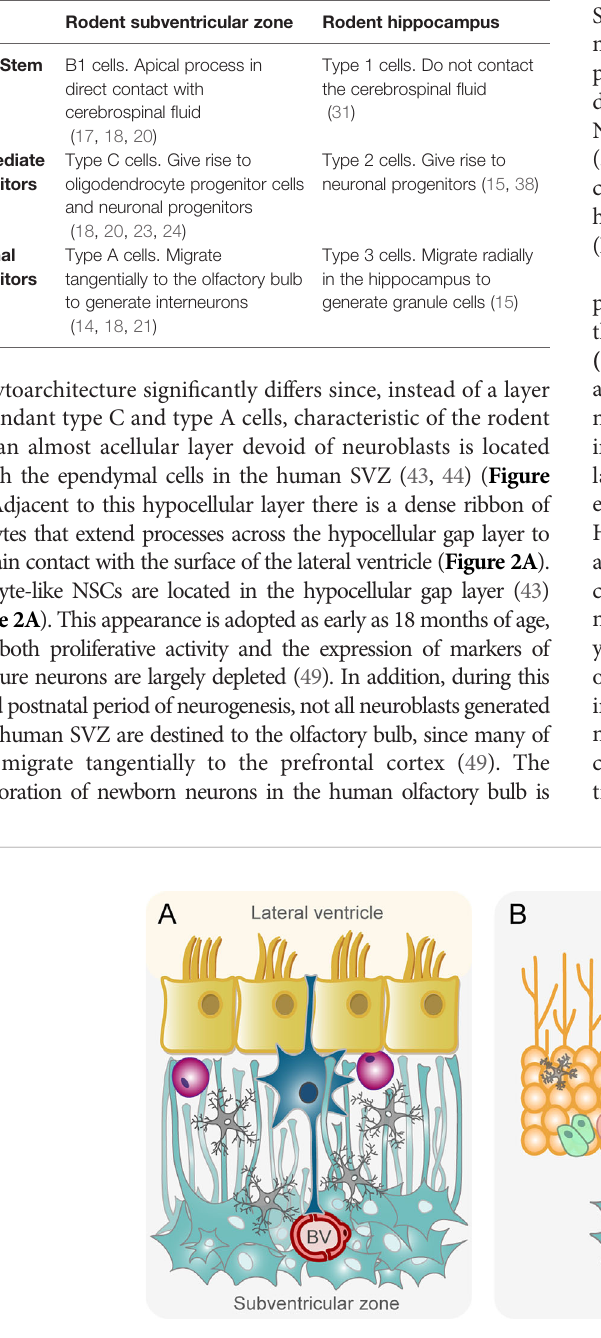
FIGURE 2 | Schematic drawing of the adult human subventricular zone (A) and hippocampus (B) . (A) Astrocyte-like neural stem cells (NSCs, in dark blue) are located beneath the ependymal cell layer (in yellow) lining the lateral ventricles, within a hypocellular layer devoid of neuroblasts and transit-amplifying progenitor cells. Microglial cells in this layer are represented in gray. Putative oligodendrocyte progenitor cells generated from NSCs are shown in purple. NSCs contact the cerebrospinal fl uid of the lateral ventricle and blood vessels (BV) of an adjacent layer consisted of a dense ribbon of astrocytes (pale blue) with processes in the hypocellular layer. (B) According to some studies (45, 46) the subgranular zone of the dentate gyrus of the adult human hippocampus contains radial glia-like neural stem cells (in pale blue) that generate proliferating intermediate neural progenitors (in pale green). These intermediate progenitors form neuronal committed progenitors (in pale orange) that become mature granule neurons (in orange). In contrast, other studies (47, 48) have reported the total absence of neuronal progenitors and immature neurons in the adult human subgranular zone. A question mark has been texted on these cells to symbolize this controversy. Other cell types of the niche are microglia (in gray) and astrocytes (in sky blue). GCL, granule cell layer; IML, inner molecular layer; SGZ, subgranular zone.